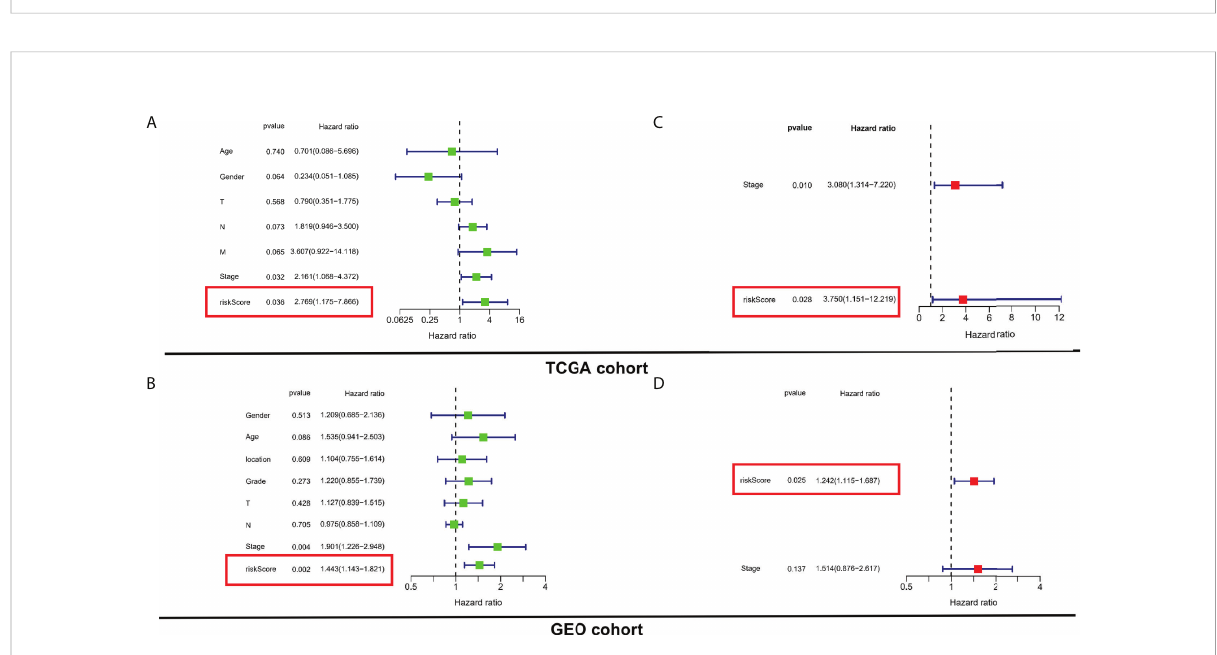
FIGURE 4 Evaluation of the prognostic values of risk strati fi cation. (A, C) Univariate and multivariate Cox regression analyses of the risk scores in TCGA. (B, D) Univariate and multivariate Cox regression analyses of the risk scores in GEO.